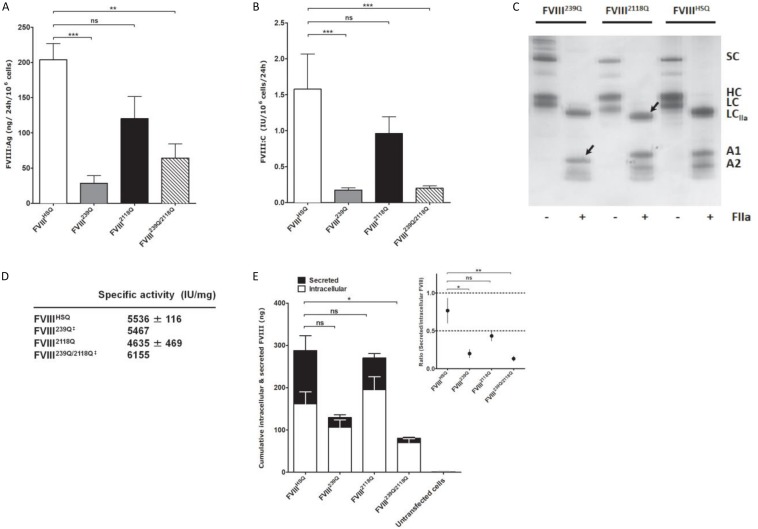
Production of recombinant wild-type and of mutated B domain-deleted FVIII lacking the N-glycosylation sites at 239 and/or 2118. Levels of FVIII:Ag (A) and FVIII:C (B) produced from BHK-M cells transfected with either the FVIIIHSQ, FVIII239Q, FVIII2118Q, or FVIII239Q/2118Q transgenes were measured by ELISA and functional chromogenic assay, respectively, and are expressed relative to 1.106 cells. Results are representatives of two independent experiments (mean ± SEM), n = 7–10 depending on the construct. Statistical comparisons between cells transfected with mutants and FVIIIHSQ were made using the two-tailed Mann-Whitney U test. (C) SDS-PAGE of FVIIIHSQ, FVIII239Q, and FVIII2118Q with and without exposure to thrombin (FIIa). SC, single chain FVIII; HC, FVIII heavy chain (A1-A2 domains); LC, FVIII light chain; LCIIa, thrombin-cleaved light chain; A1, A1 domain; A2, A2 domain. Arrow heads depict the deglycosylated A1 domain and light chain for FVIII239Q and FVIII2118Q, respectively. (D) FVIII activity was measured by functional chromogenic assay and protein concentration was evaluated by absorbance at 280 nm. ‡FVIII239Q and FVIII239Q/2118Q were purified and tested only once. (E) Levels of secreted and intracellular FVIII produced by transfected and untransfected BHK-M cells were measured after 24 h of culture. Statistical analysis was performed on intracellular levels of FVIII using two-way ANOVA test. The inset depicts the ratios of secreted versus intracellular FVIII levels. Statistical comparison was assessed by a t-test. Data represent means ± SEM of three independent experiments. *P < 0.05, **P < 0.01; ***P < 0.001; ns: not significant.